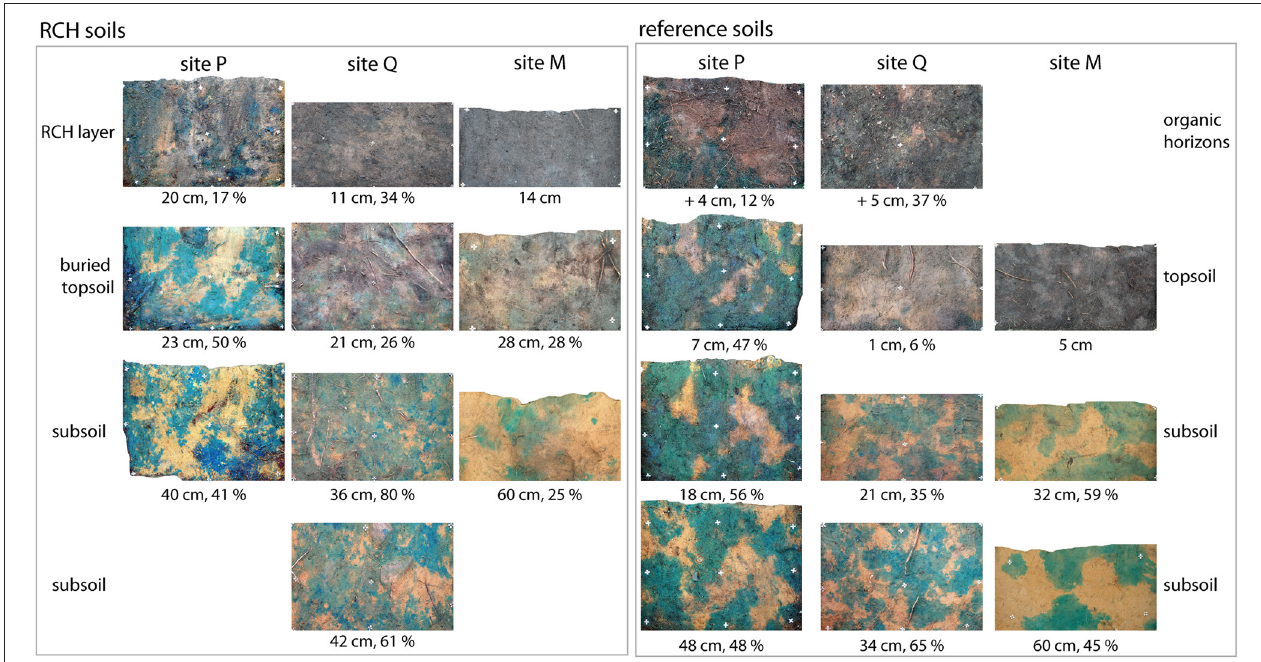
FIGURE 5 | Dye tracer stain patterns for horizontal profiles and values of relative dye coverage integrated over the profiles. No horizon-specific quantification is given for the RCH layer and topsoil of site M, where tracer stains can hardly be distinguished from the dark substrate.